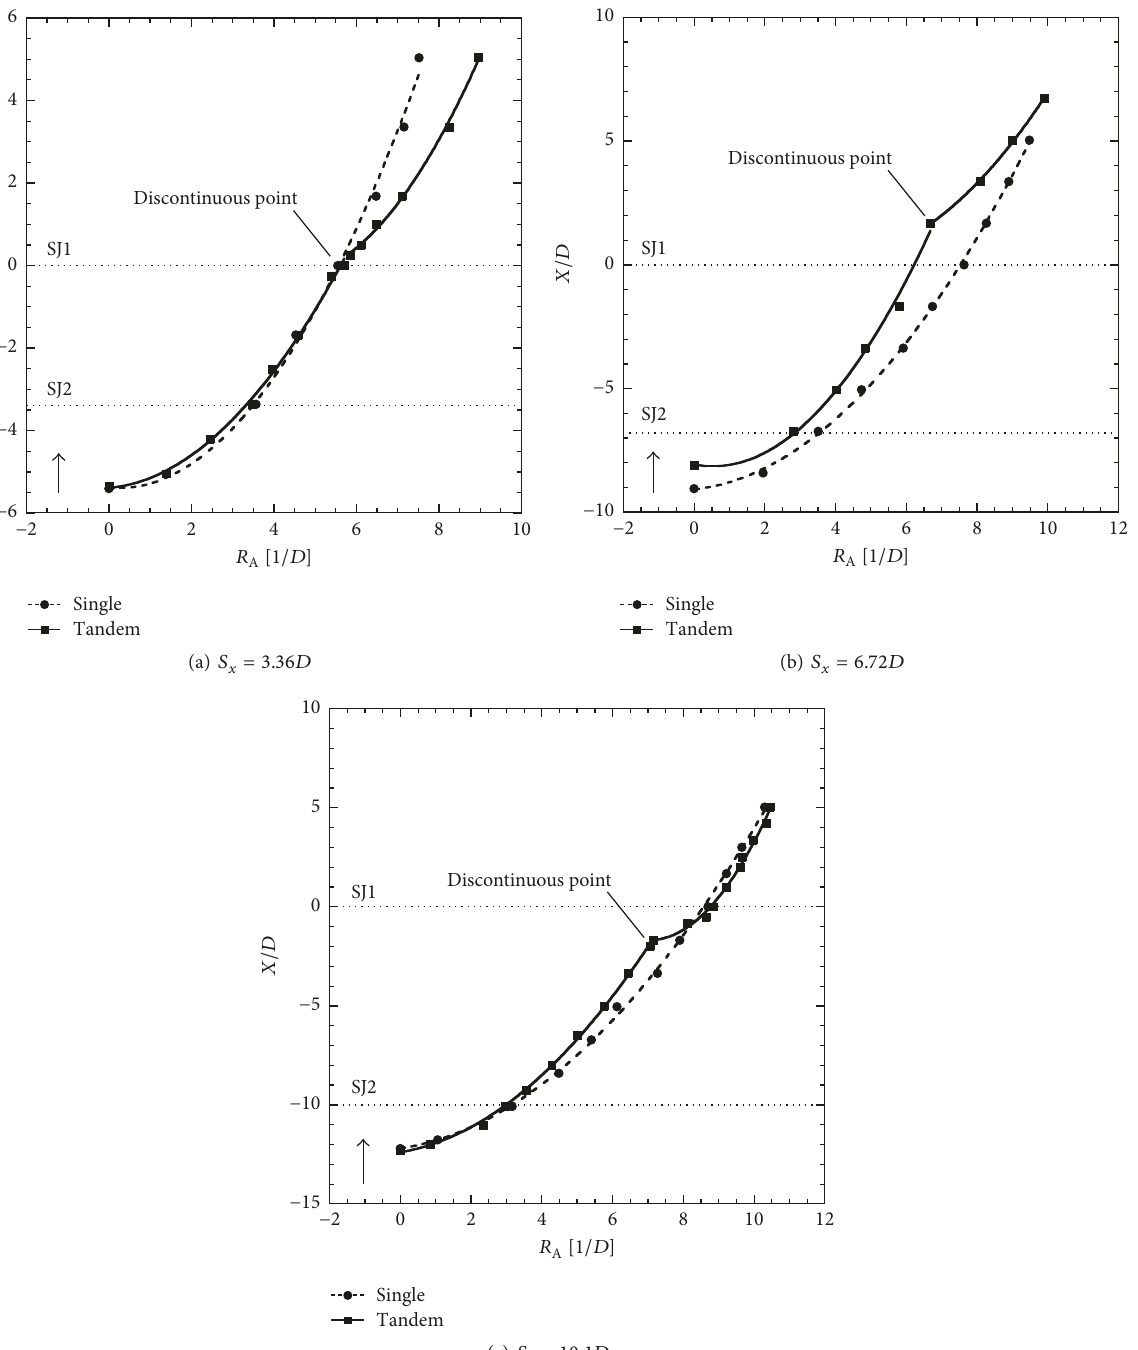
Figure 15: Comparison of half width of region A induced by single and tandem dual injection(s) with each injection hole spacing. Plots indicate loci of maximum St in region A on each 𝑋/𝐷 position. ↑ indicates the freestream